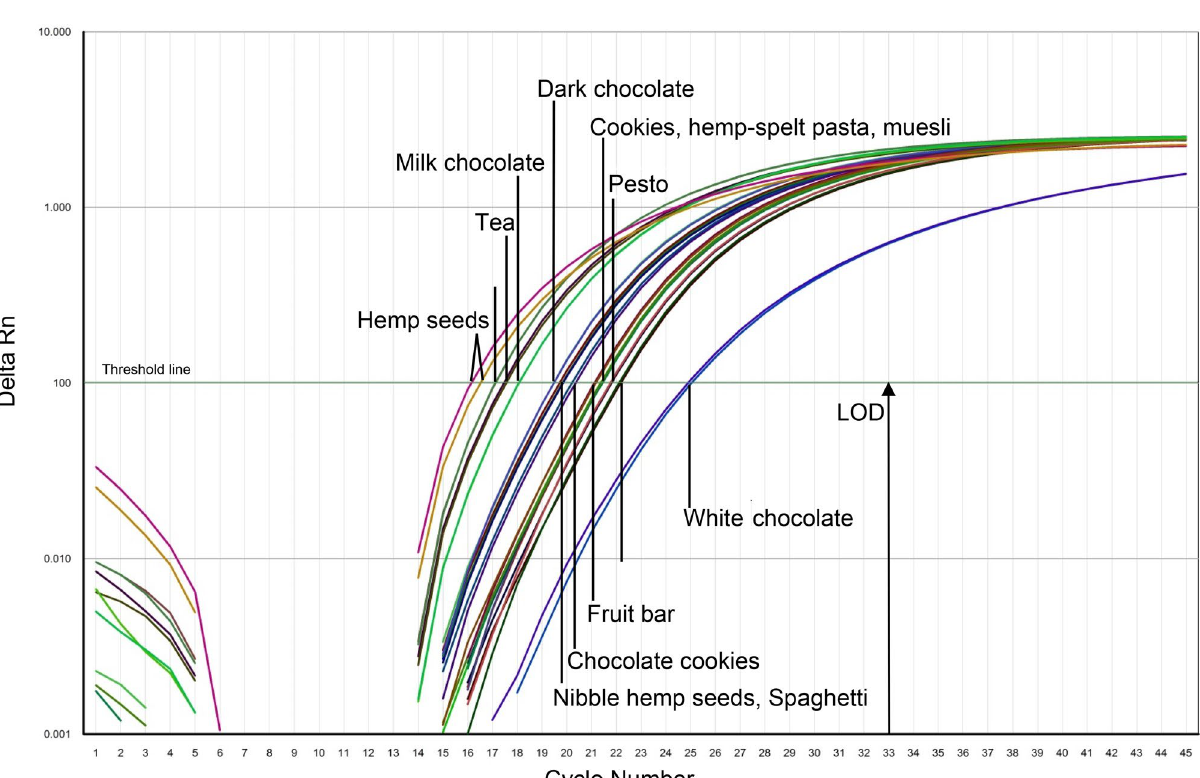
Figure 4. Results of analysing diverse foodstuff obtained with 5 ng/µl DNA per tube. Hempseeds were analysed as reference material